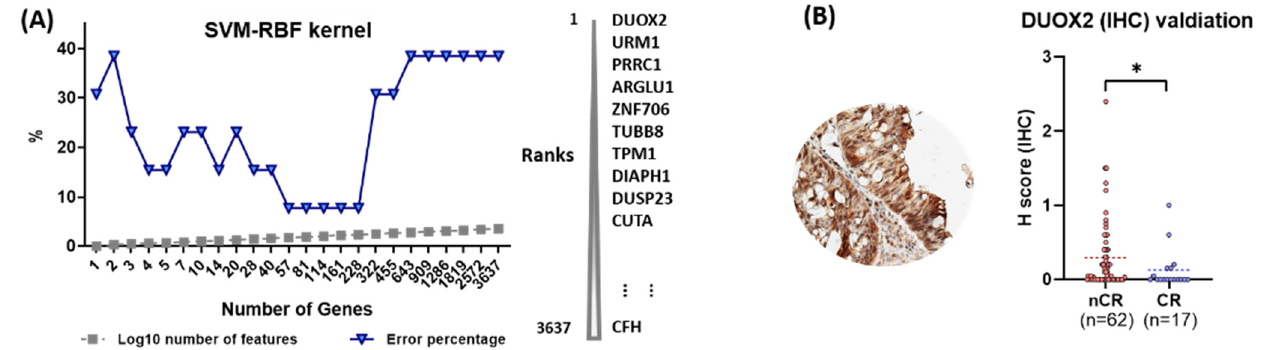
Figure 4. ( A ) Machine learning approaches to measure the predictive power of proteins for CCRT response. ( B ) Immunohistochemical (IHC) validation of dual oxidase 2 (DUOX2) as a predictive biomarker for CCRT response (statistical significance, * p -value < 0.05).